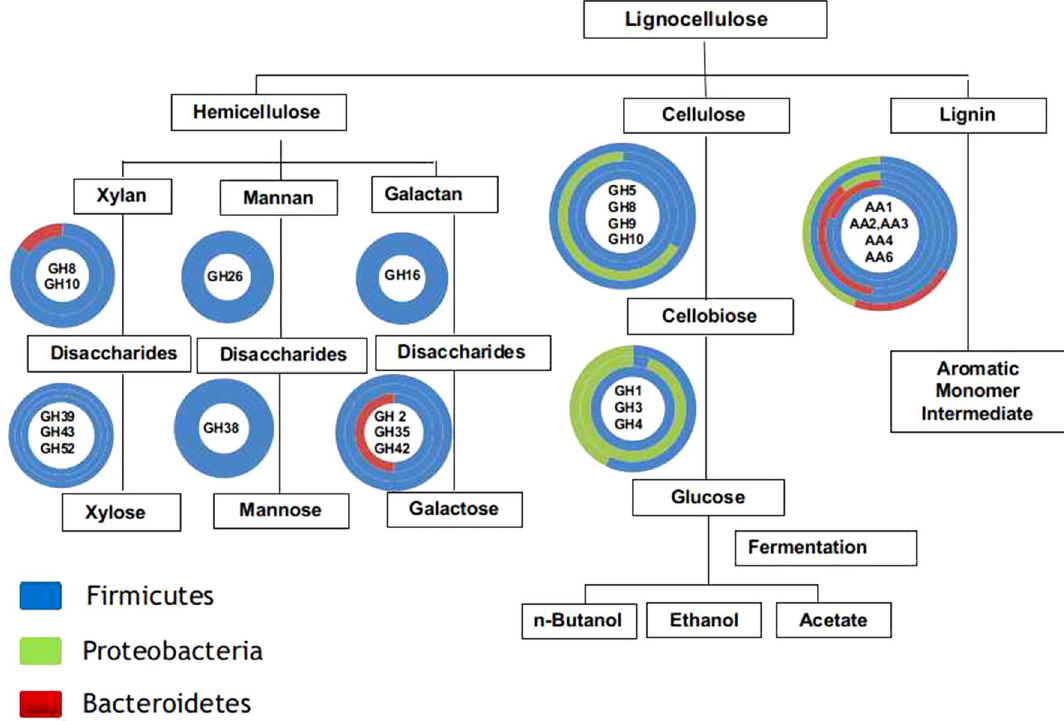
Figure 9. Lignocellulose degradation pathway and its related enzymes found in bacteria identified at the genus level in the RSV consortium. The relative abundance of GH families in representatives of bacterial phyla has been shown as concentric circles with inner circle corresponding to first GH in the